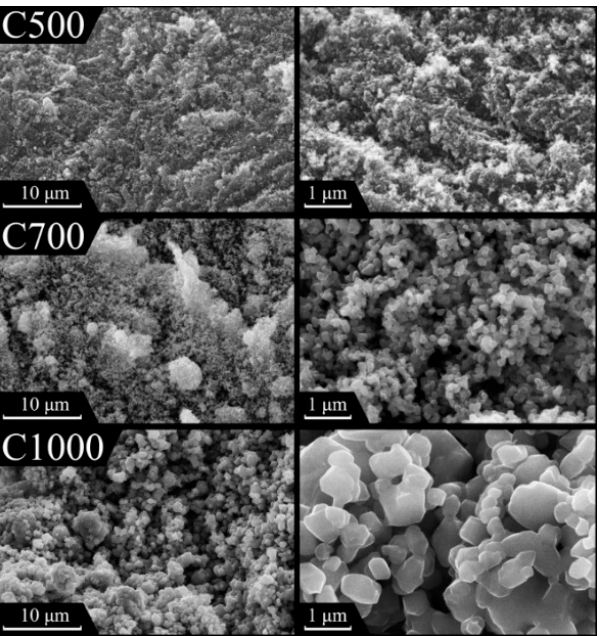
Figure 1. The SEM images of TiO 2 samples calcinated at different temperatures.